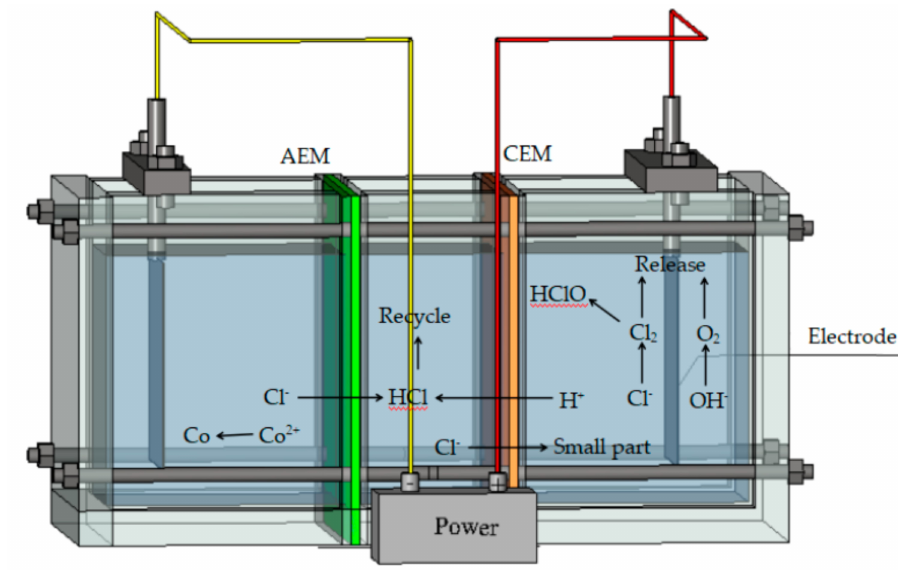
Figure 1. Schematic of electrolysis unit for “double membrane three chamber” cobalt recovery process (CEM is cation exchange membrane; AEM is anion exchange